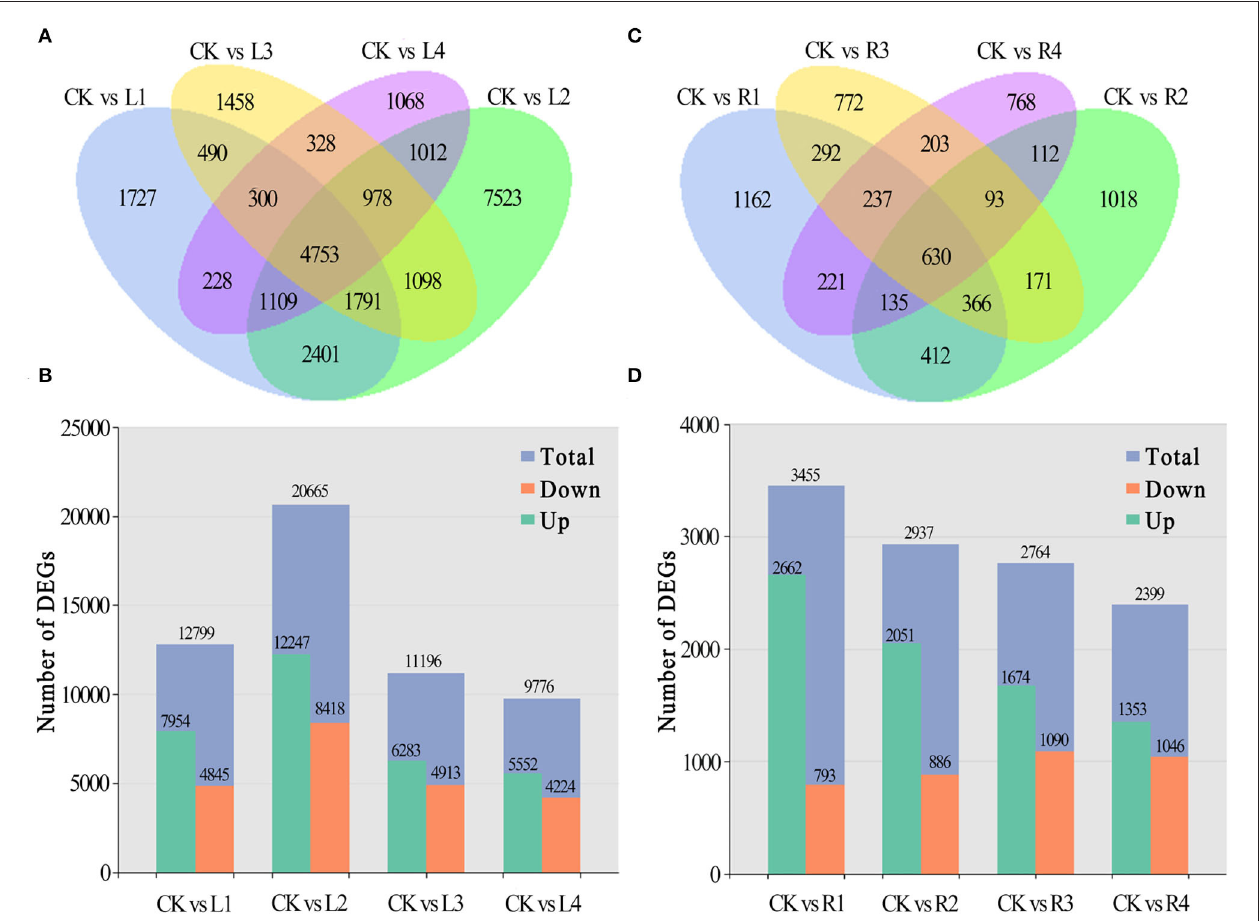
FIGURE 3 | Distribution of DEGs in different periods. (A,B) Numbers of DEGs in leaves and roots of smooth bromegrass under different stress times compared with the control; (C,D) Summary of the numbers of up- and downregulated DEGs in leaves and roots of smooth bromegrass.